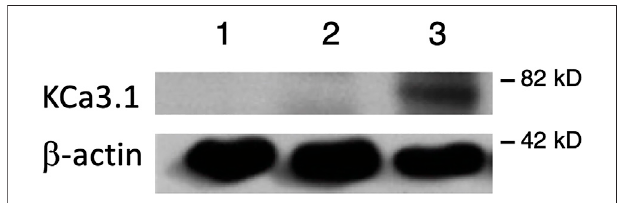
FIGURE 1 | Membrane location of KCa3.1-BLAP stably expressed in FRT cells. The sidedness experiments con fi rm the expression pattern of KCa3.1 on the basolateral membrane ofFRT cells. Untransfected FRT cells or FRT-KCa3.1-BLAP cells weregrown on Transwell ™ fi lter inserts toform a monolayer. Untransfected cells were labeled with streptavidin on both sides of the fi lter; while FRT-KCa3.1-BLAP cells were labeled either on the apical side or the basolateral side of the fi lter insert. A band was only observed in the sample that was labeled basolaterally near the 82 kD mark. Lane 1: untransfected FRT, Lane 2: KCa3.1-BLAP- + Apical streptavidin labeling, and Lane 3: KCa3.1-BLAP + Basolateral streptavidin labeling. Each lane was loaded with 30 µg ofprotein and β -actin was used as aloading control ( n